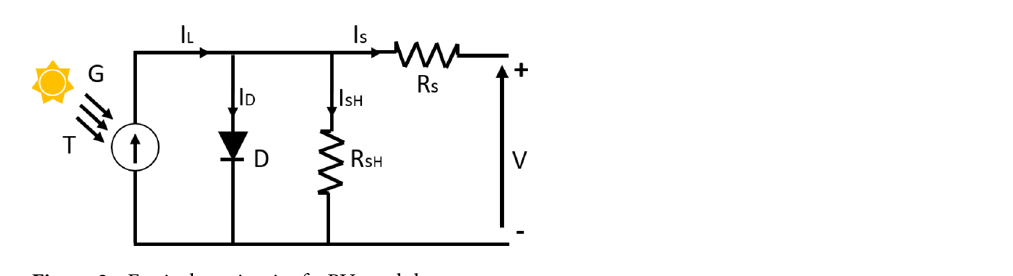
Figure 2. Equivalent circuit of a PV